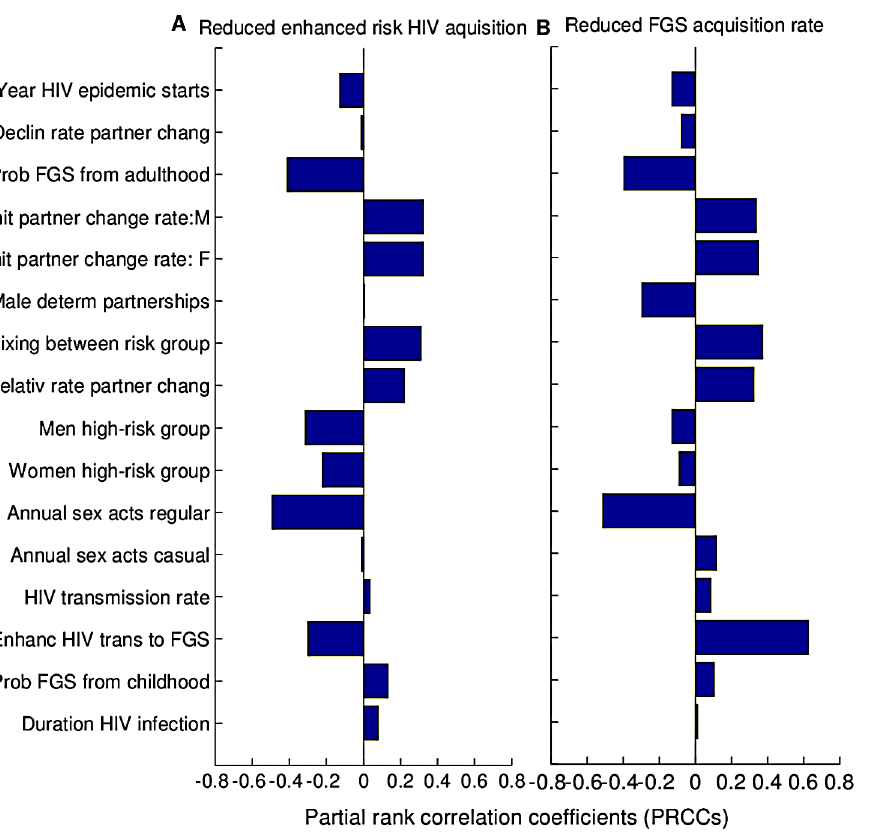
Figure 4. Partial rank correlation coefficients (PRCCs). A parameter was considered to be important in affecting the effectiveness of mass drug administration with praziquantel for impact on HIV transmission if |PRCC| . 0.4. Specifically, probability of acquiring FGS from adult infection and the annual number of sex acts in low risk partnerships were the most important parameters for the first scenario (A), and the coefficient by which FGS enhances HIV transmission rate per sex act and the annual number of sex acts in low-risk partnerships were the most important parameters for the second scenario (B).